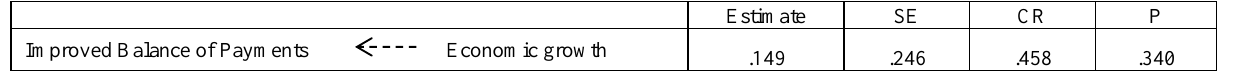
Table 3. Regression Weights Composite Model